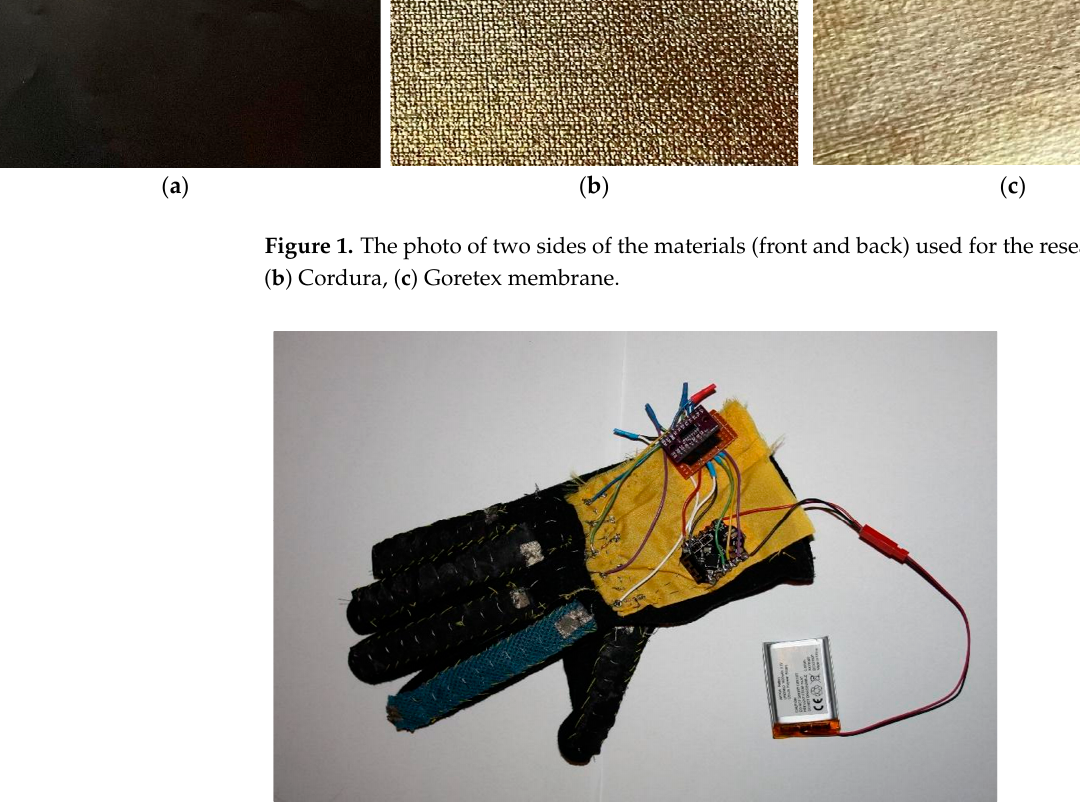
Sensors 2022 , 22 , x FOR PEER REVIEW Figure 2. Prototype of a glove for translating sign language. Figure 2. Prototype of a glove for translating sign language.